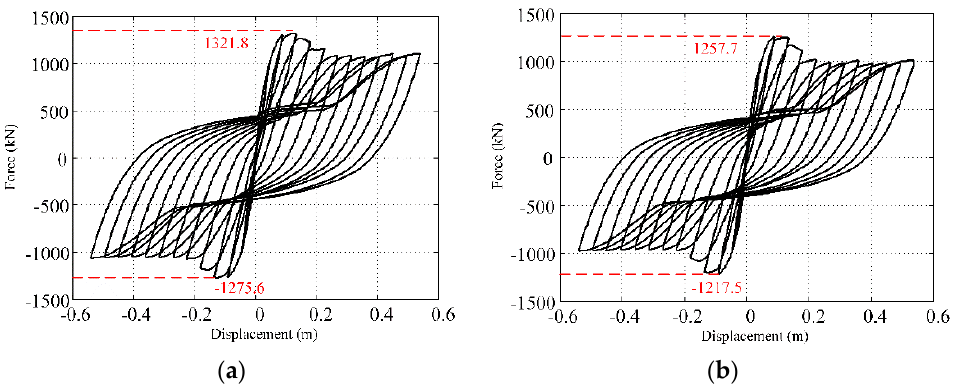
Figure 2. Hysteretic curves of a bridge pier with pitting corrosion. ( a ) Pristine, ( b ) 5%